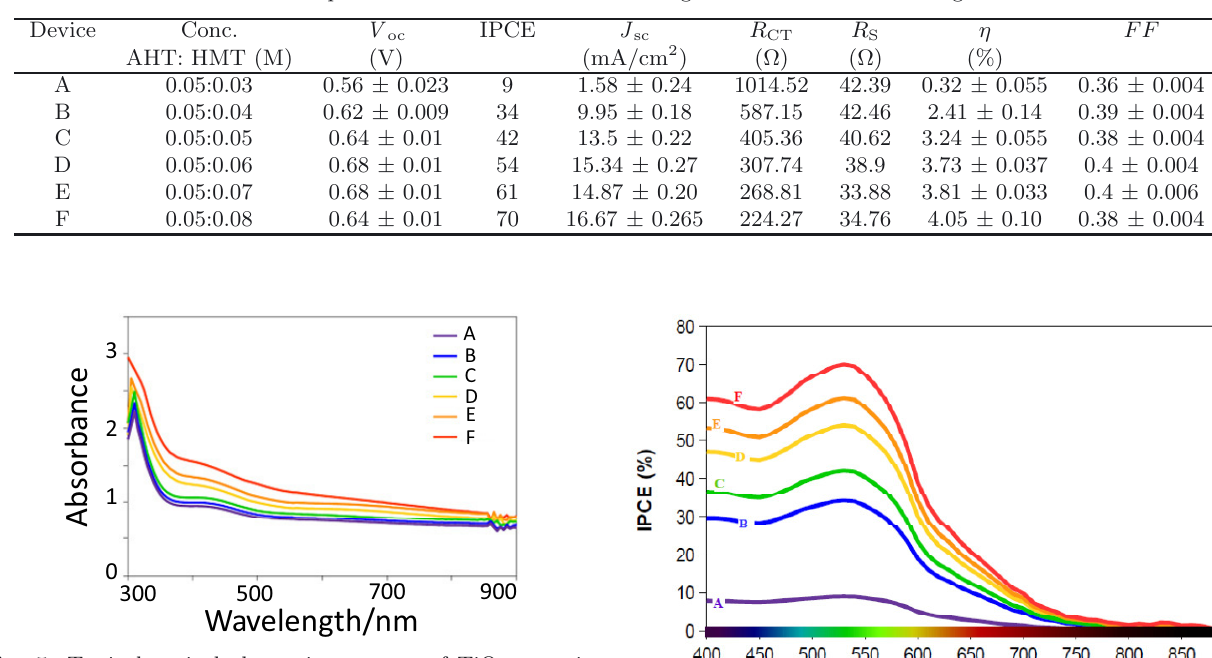
Fig. 5. Typical optical absorption spectra of TiO 2 nanorice prepare using different HMT concentrations.